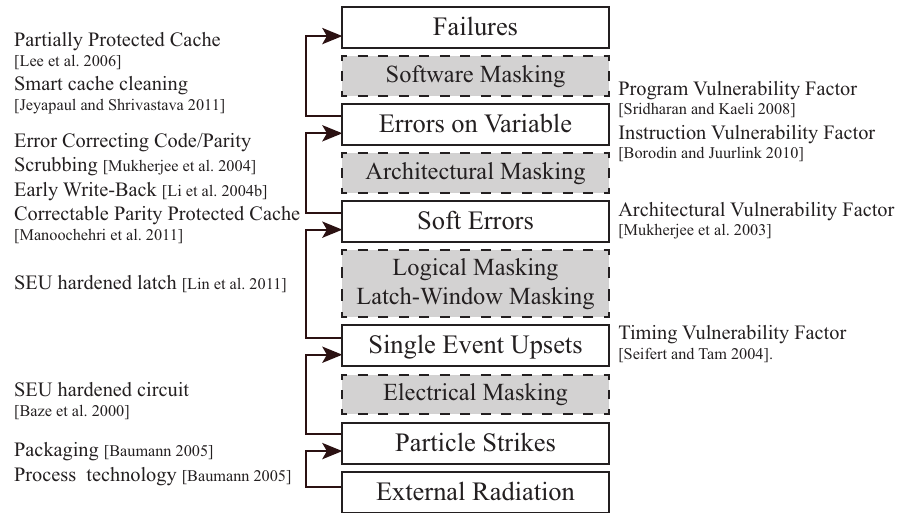
Figure 1. Masking effects, protection techniques, and vulnerability estimation from circuit-level to